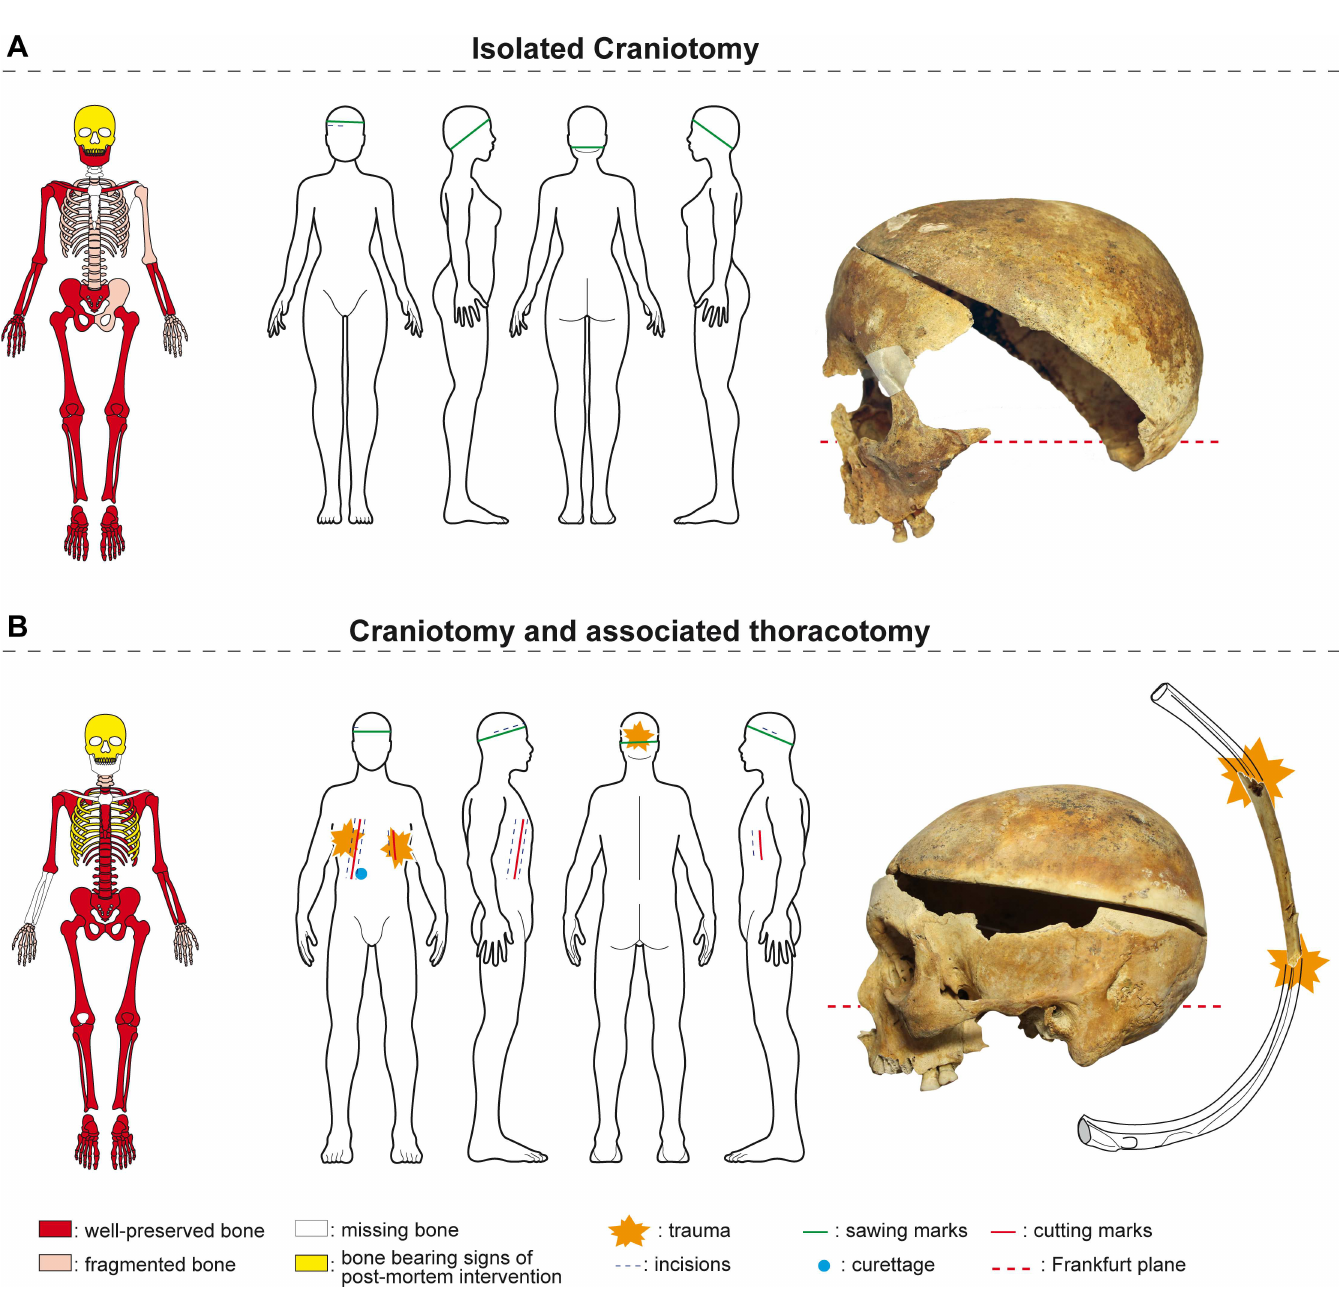
Fig 3. Bones lesions. Representation of skeletal preservation,anatomical location, types of lesionsand bone pictures. (A) Isolated suboblique craniotomy (grave 1209). (B) Subhorizontal craniotomy and associatedthoracotomy, cut marks on the lower edges of the 5 th left rib with secondary fractures (grave 1226). Sawing is attested by tooth marks and / or scrappingmarks. The deep cutting grooves evidencecrushing and repetitive attempts at severing the ribs and / or sternum using pruningshears or choppers. The fine groovesthat can be observedon the external side of the bones are due to scalpel incisions in order to remove teguments. Those on the internalside appearas a consequence of curettage the ribs and / or os